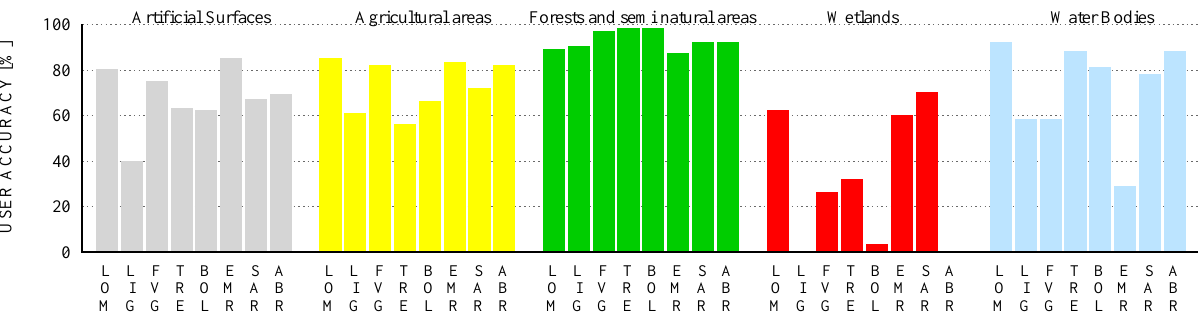
Figure 9. Comparison between GlobeLand30 2000 and Italian regional datasets (I reclassification, no buffer case): overall accuracy (OA), allocation disagreement (AD), quantity disagreement (QD) for each dataset.